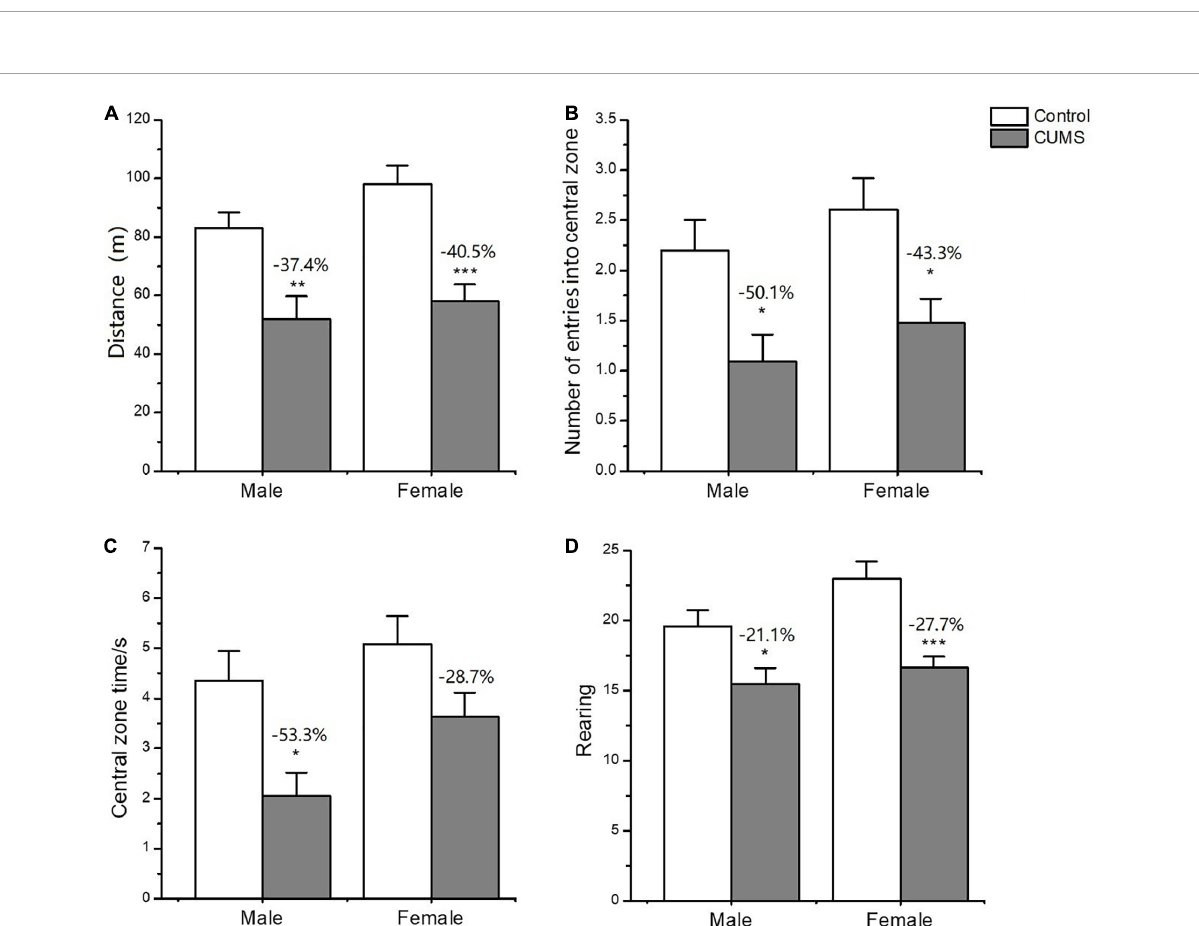
FIGURE4 Depressive-like behavior induced by CUMS in OFT of male and female rats. (A) The distance moved in OFT. (B,C) The number and time spent on entries into central zone. Rearing number in OFT (D) . * p < 0.05, ** p < 0.01, and *** p < 0.001 vs. control with same